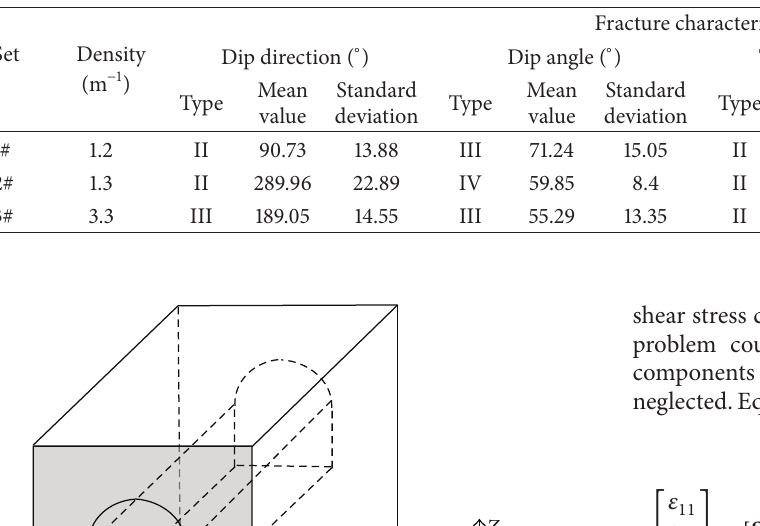
Table 1: Characteristics of 3 sets of discontinuities for the slope exposure.